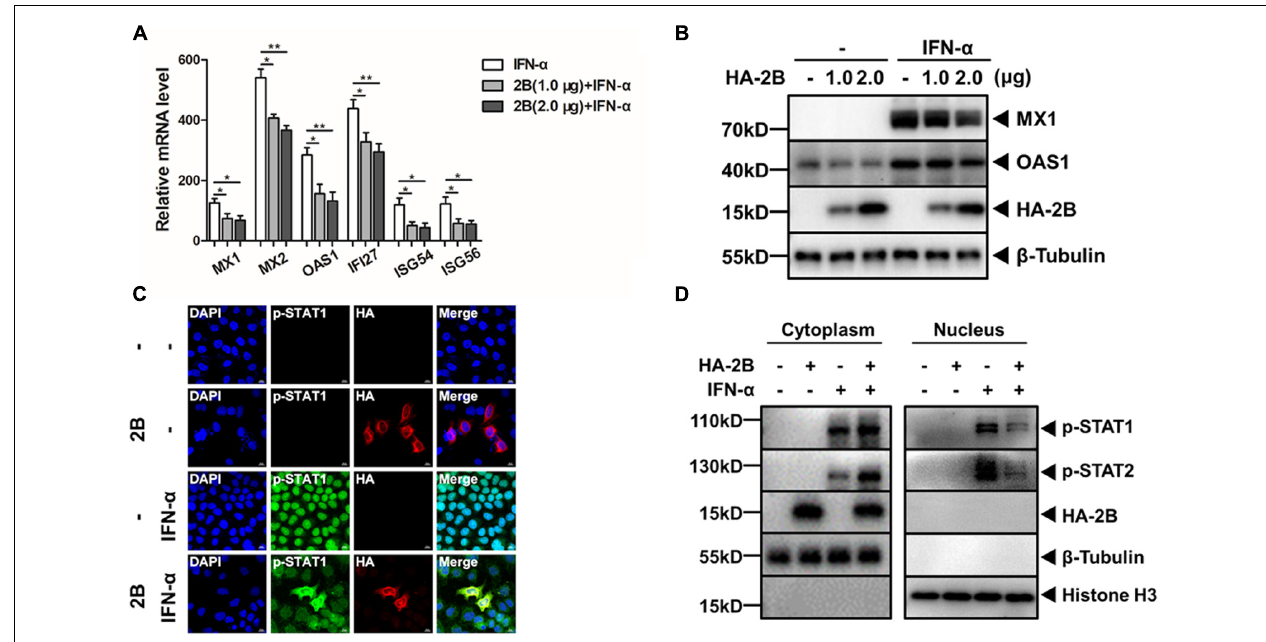
FIGURE 1 | EV-A71 2B inhibited type I interferon responses. HeLa cells were transfected with plasmids expressing HA-tagged 2B, followed by treatment with or without IFN- α (25 ng/ µ L). (A) EV-A71 2B inhibited the induction of ISGs induced by IFN- α . Total RNA was prepared from the cells for real-time RT-PCR to measure ISG mRNA transcripts. Values represent mean ± SD from triplicates of independent experiments.* P <0.05; ** P <0.01. (B) EV-A71 2B inhibited the induction of MX1 and OAS1. The cell lysates were prepared for western blot analyses with antibodies for MX1 and OAS1. (C) EV-A71 2B prevented p-STAT1 from translocation into the nucleus upon IFN- α stimulation. The cells were fixed and premeabilized for subsequent staining with antibodies for HA tag and p-STAT1, which were subjected to confocal microscopy. Magnification, × 630. (D) Translocation of p-STAT1 and p-STAT2 was blocked by 2B. The cytosolic and nuclear fractions were prepared from the cell lysates, which were further subjected to western blot analyses with antibodies specific for p-STAT1 and